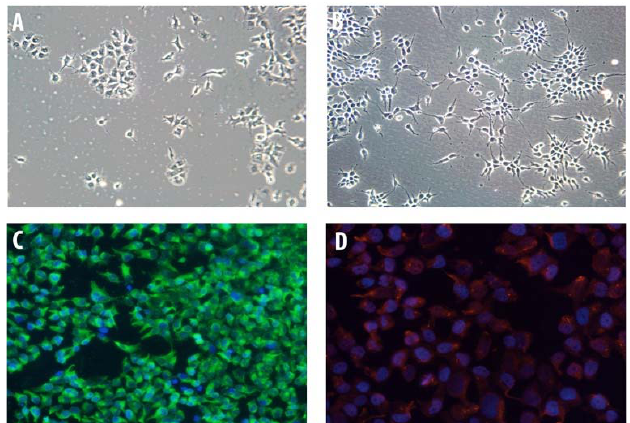
Figure 1. Human oligodendroglioma (HOG) cell characterization. HOG cells were grown on poly ‐ L ‐ lysine ‐ coated cover slips for five days. ( A ) Undifferentiated HOG cells showed a flat and epithelioid ‐ like morphology with large round nuclei and short processes. ( B ) After two days in differentiation media, HOG cells became more mature with a fried ‐ egg phenotype, spindle ‐ shaped nuclei, and long processes. ( C ) For immunocytochemical characterizations, differentiated HOG cells were fixed, permeabilized, and stained for myelin basic protein (MBP) followed by fluorescein ‐ 5 ‐ isothiocyanate (FITC) secondary antibody. ( D ) Cells were stained for 2 ′ ,3 ′‐ cyclic nucleotide ‐ 3 ′‐ phosphodiesterase (CNPase). Immunocytochemical characterization of differentiated HOG cells showed that most cells expressed ( C ) MBP and ( D ) CNPase.